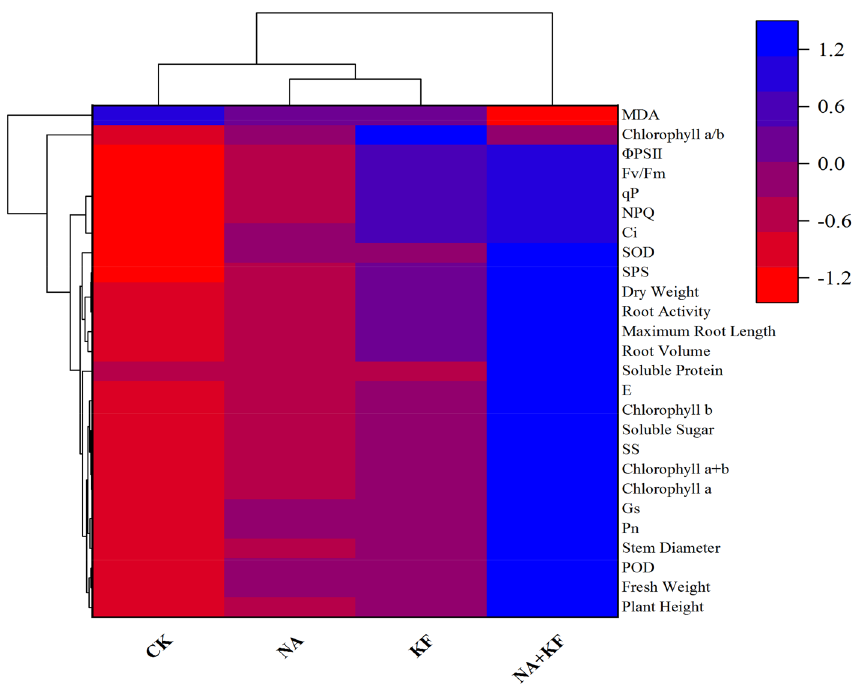
Figure 8. Cluster heat map analysis summarizing tomato seedlings responses to different treatments. NA, 5 mg·kg −1 NA; KF, 60 mg·kg −1 KF; NA + KF, 5 mg·kg −1 NA and 60 mg·kg −1 KF. Results are visualized using a false color scale with blue indicating an increase and red a decrease of the response